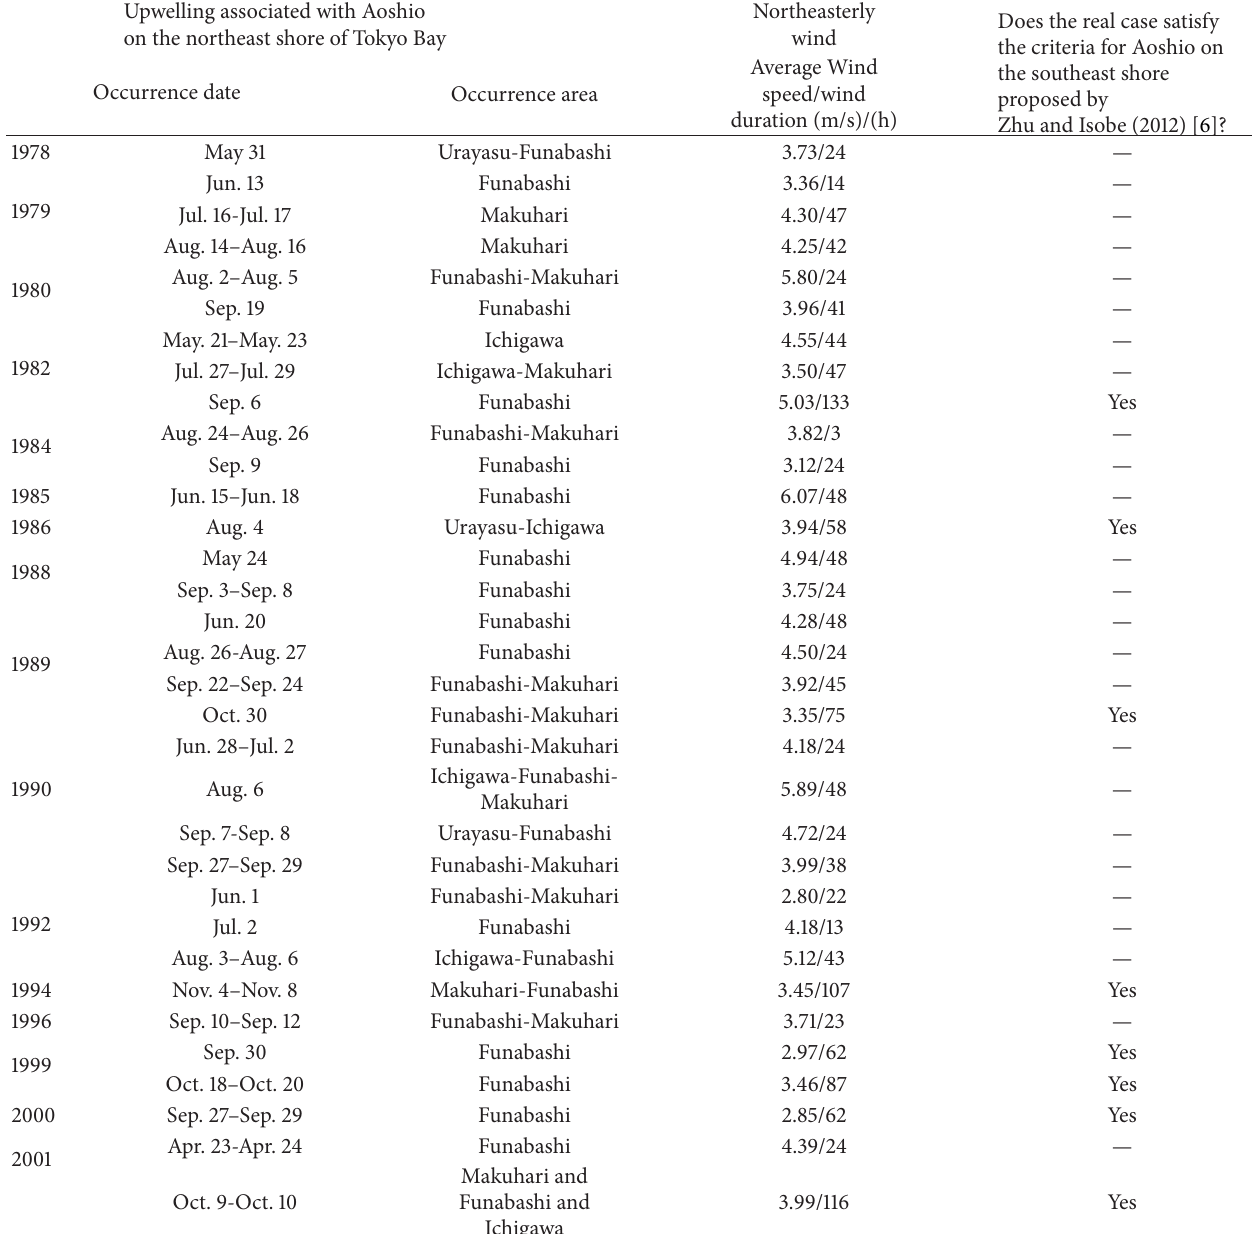
Table 4: Occurrence dates, occurrence areas, and wind conditions of real cases of Aoshio observed on the northeast shore of Tokyo Bay from 1978 to